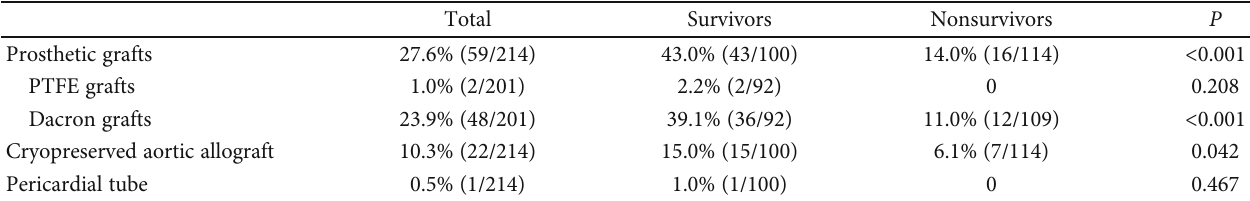
Table 4: Summary of grafts used for aortic